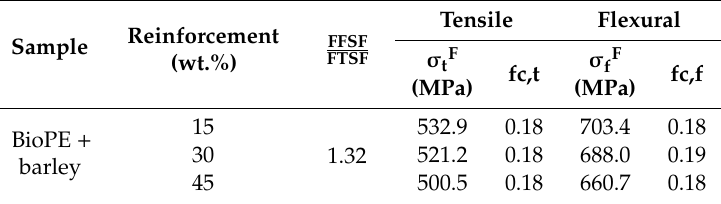
Table 4. Intrinsic flexural ( σ fF ) and tensile strength ( σ tF ) of the fibers, and flexural (fc,f) and tensile (fc,t) coupling factors. Tensile Flexural Reinforcement FFSF Sample FTSF (wt.%) BioPE +